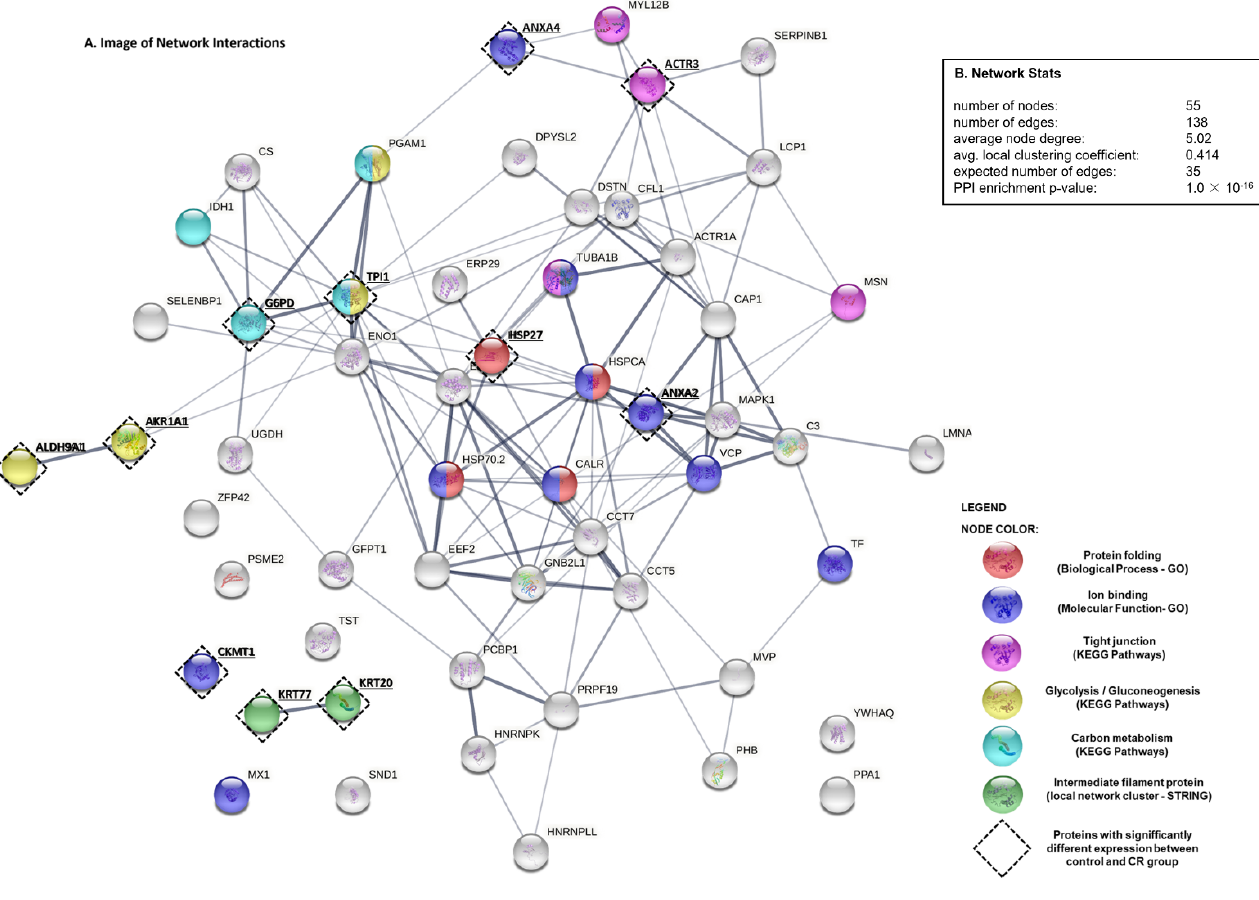
Figure 3. STRING analysis of proteins identified by MALDI-TOF MS and MALDI FT-ICR MS: ( A ) Protein–protein interaction image displaying nodes and edges between all identified proteins found in the cecal mucosa of nursery pigs. Proteins are represented as nodes. Various thickness of the edges indicates the strength and nature of the presented interactions detected between the proteins. Different colours of nodes shows selected gene ontology (GO) terms such as biological process, molecular function, KEGG pathways and local network cluster (STRING) that are associated with the porcine cecal proteins. Black dotted edgings along selected nodes represent cecal proteins that were found to be significantly altered in the group of pigs fed a diet enriched with 4% dried chicory root. Full name of identified proteins along with the corresponding genes can be found in Tables 4 and 5; ( B ) network statistics presenting data concerning included number of nodes and edges, the average node degree, the average local clustering coefficient, the expected number of edges, and the protein–protein interaction (PPI) enrichment p -value.